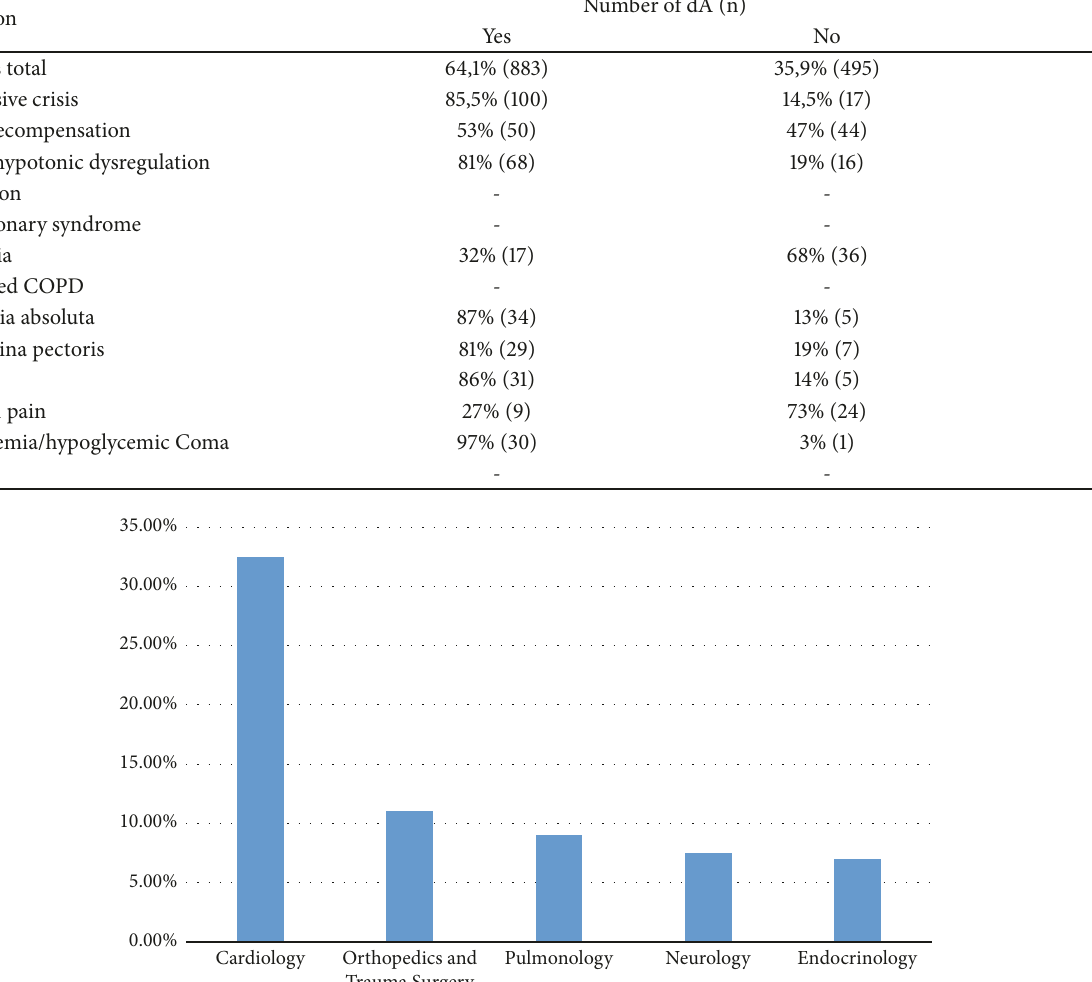
Figure 2: Distribution of the prehospital mission-related hospital discharge diagnoses by the prehospital emergency physician, summarized by